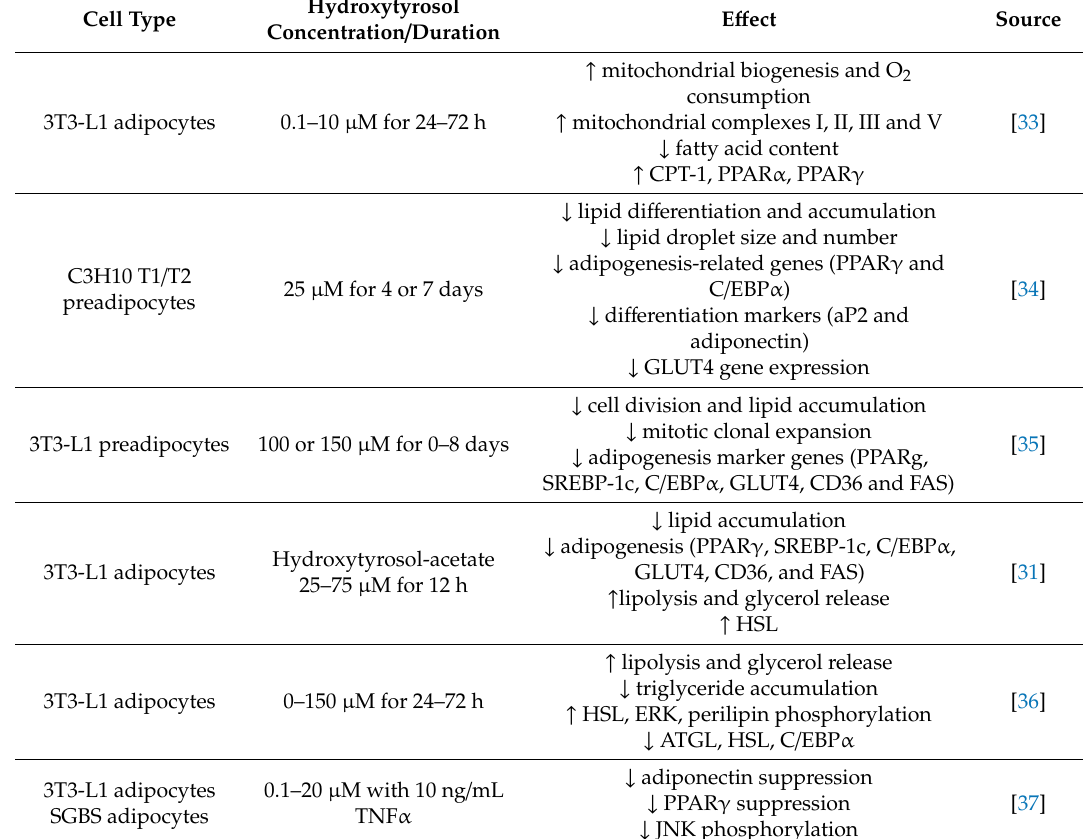
Table 4. E ff ects of hydroxytyrosol on